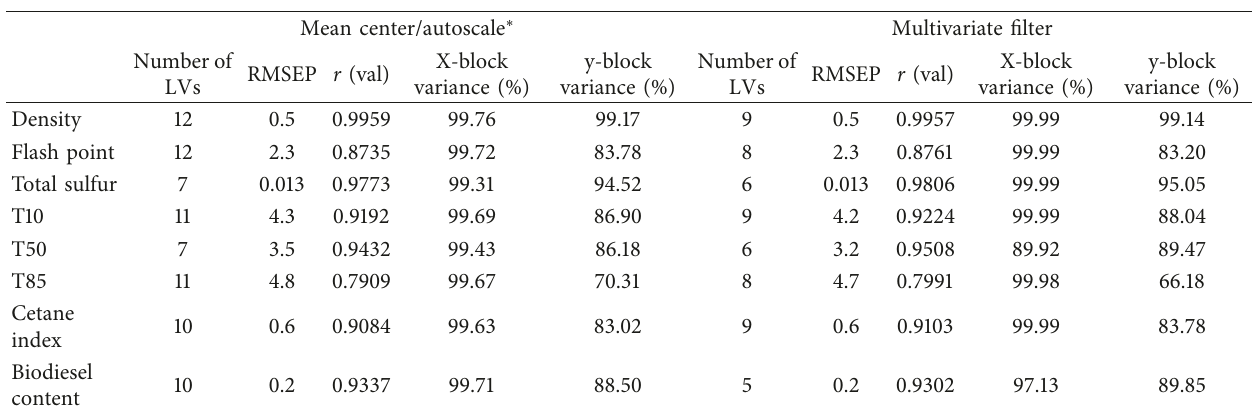
Table 5: Comparison between mean center/autoscale and multivariate filters.